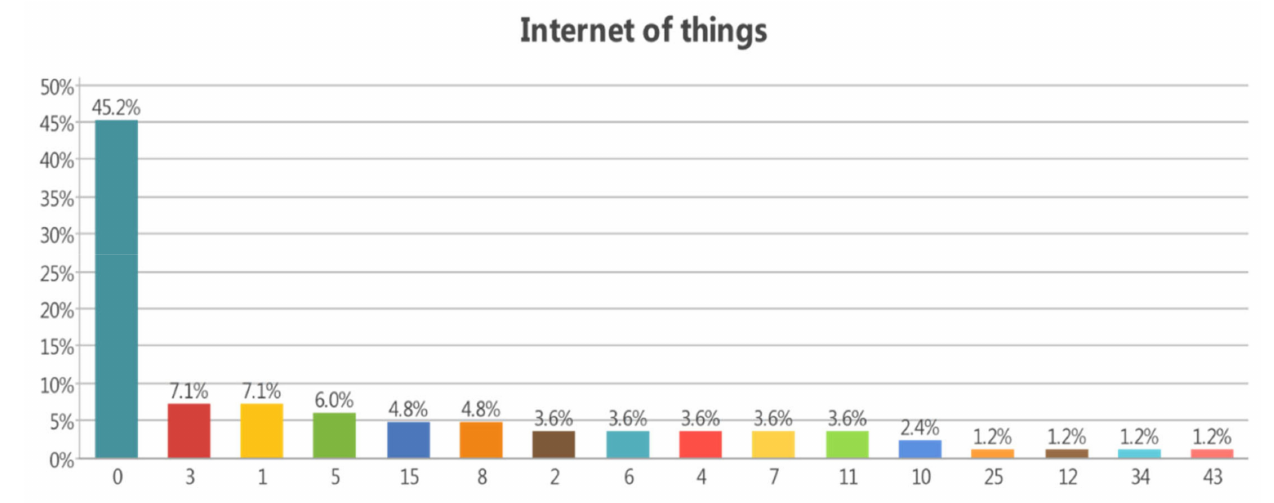
Figure 9. Significance of the IoT and its appearance in past studies.